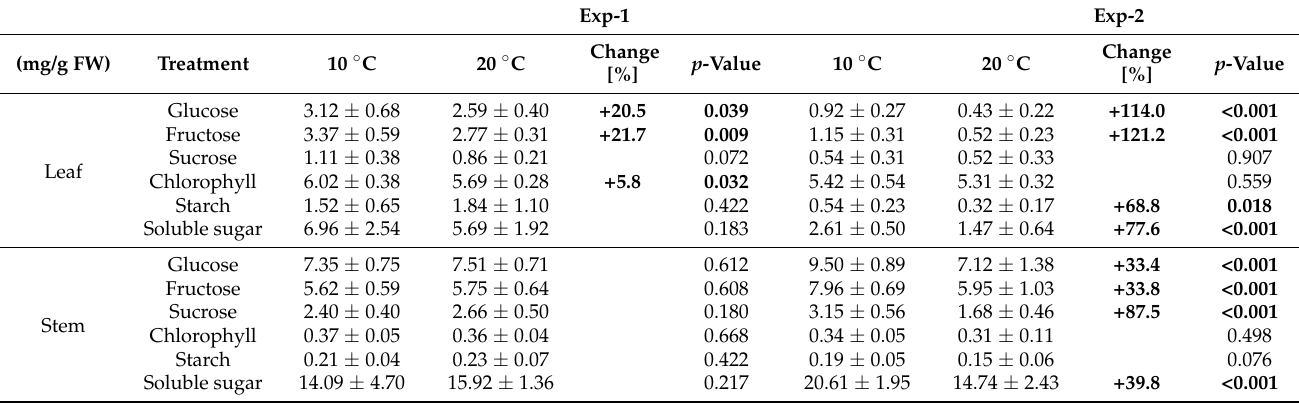
Table 3. Soluble sugars, total chlorophyll, and starch concentration (mg/g FW) of leaves and stems of Chinese broccoli under different root temperatures and harvest dates in Exp-1 and Exp-2. Significant differences ( p < 0.05) were indicated in bold. FW: fresh